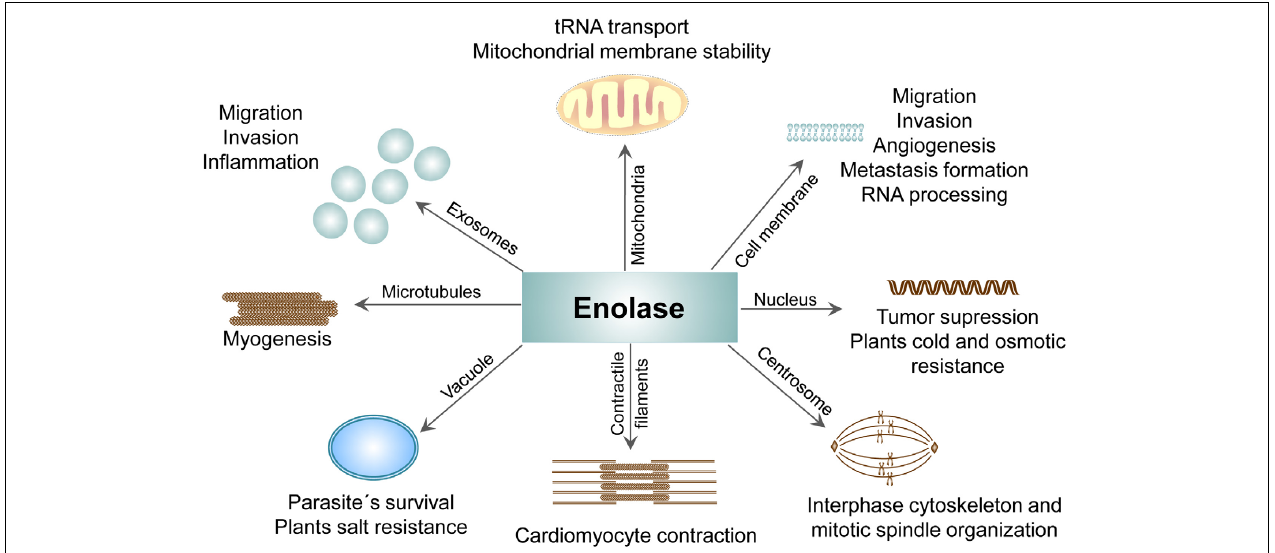
FIGURE 5 | Compartment-specific activities of ENO protein. The presence of ENO in different cellular compartments and its contribution to the physiological as well pathological processes.